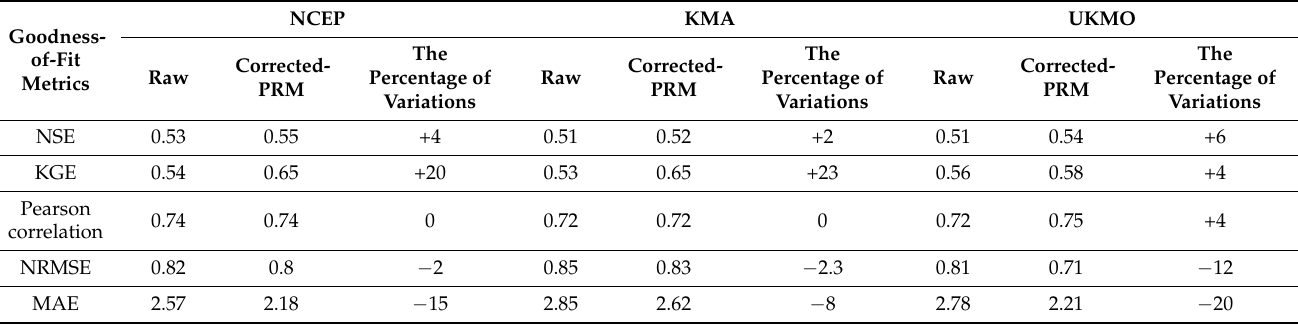
Table 9. Goodness-of-fit metrics for raw and corrected ensemble precipitation